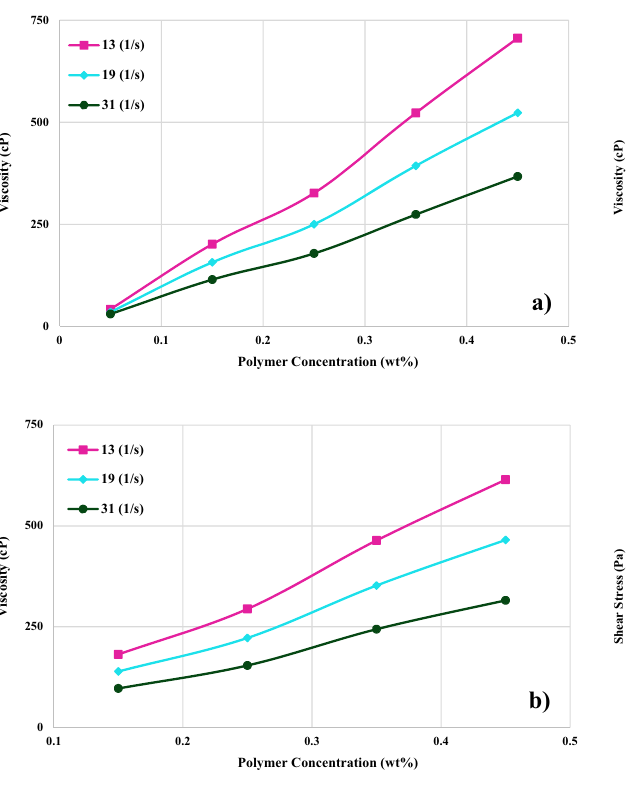
Figure 4: Viscosity of the polymer at di ff erent polymer contents: ( a ) T = 25°C and ( b ) T = 80°C. Figure 5: Rheological behavior of polymer sample ( fi xed polymer content of 0.26 wt% ) at two di ff erent temperatures: ( a ) shear vis - cosity and ( b ) shear stress vs shear